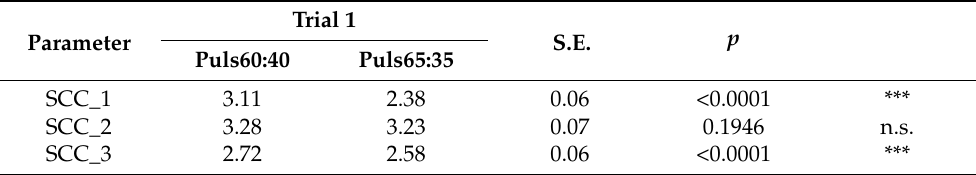
Table 3. Least-square means (LSM), standard error (S.E.), and statistical difference ( p -value) of the somatic cell count in the 3 measurements (1–3) in chronological order for Trial 1.